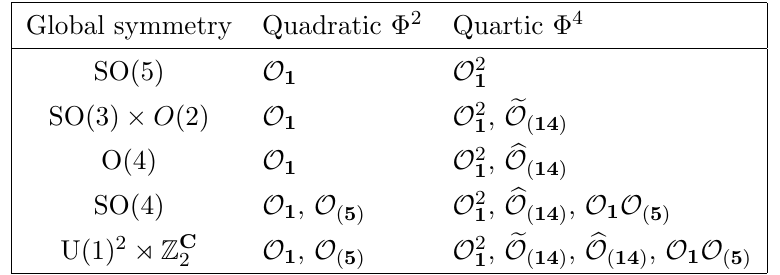
Table 1 . Relevant deformations of T ( k )